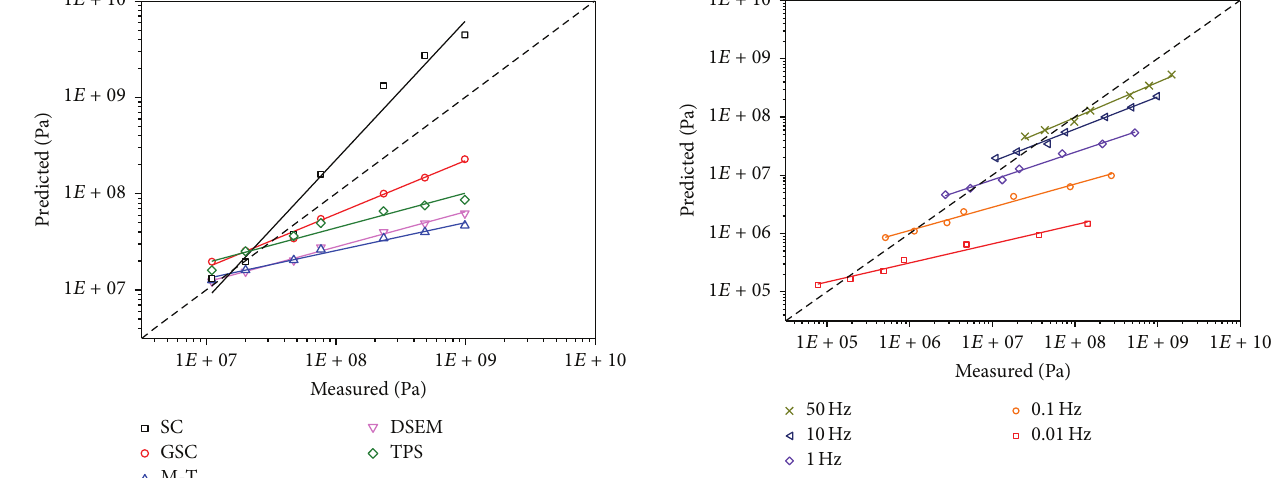
Figure 9: Effect of filler volume fraction on the prediction accuracy.